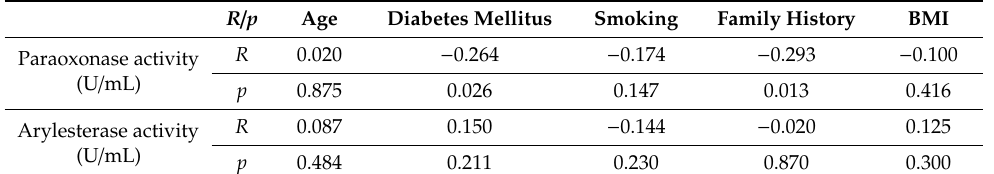
Table 2. Correlation of serum paraoxonase activity and risk factors of coronary heart disease in group of patients ( R , correlation coefficient; p , value according to Spearman test).